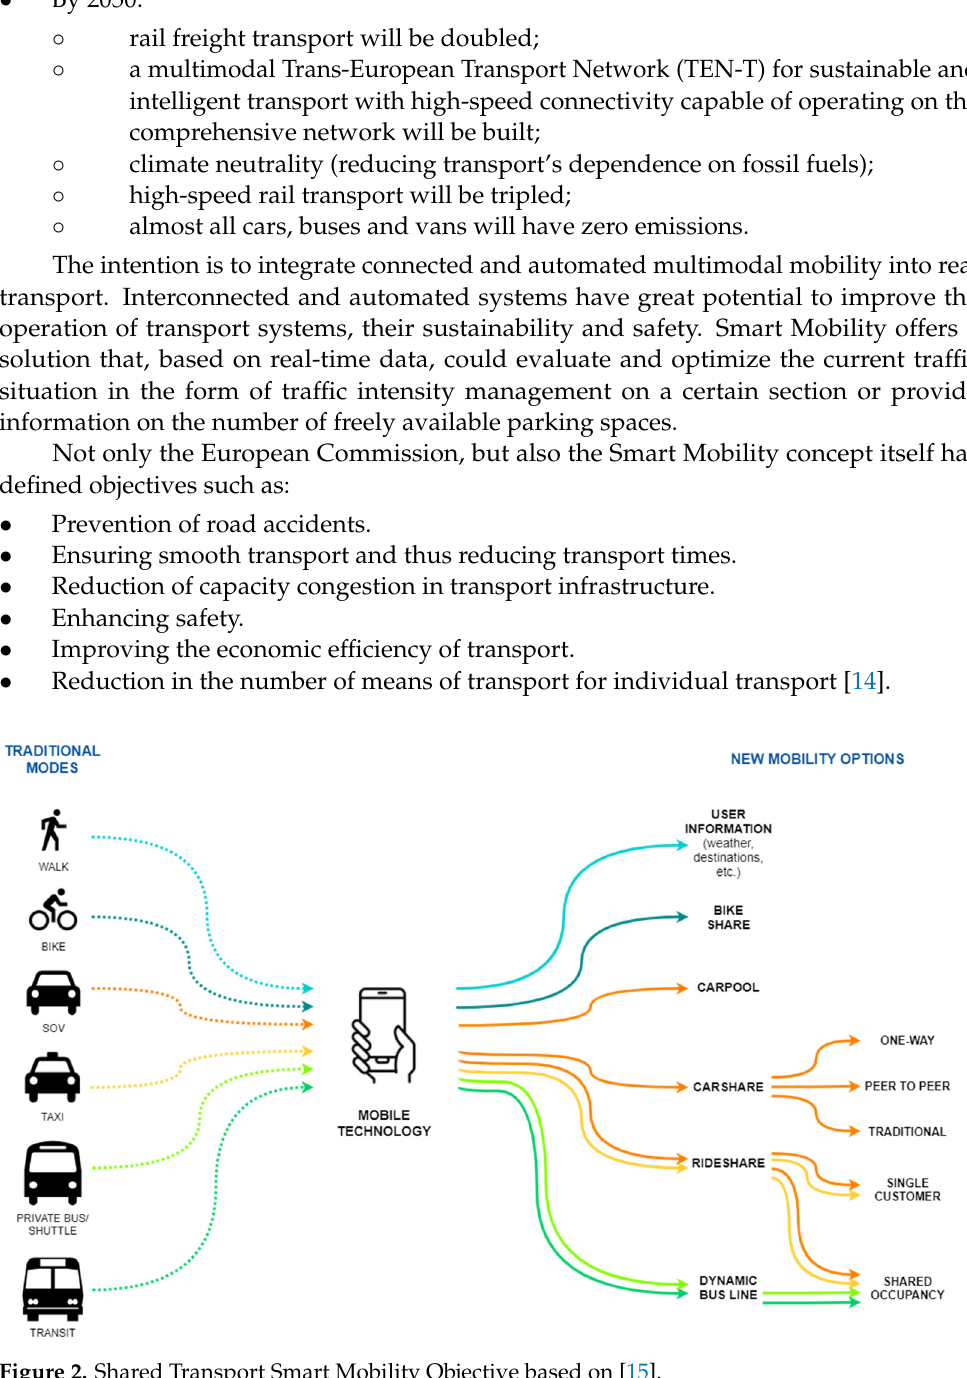
Figure 2. Shared Transport Smart Mobility Objective based on